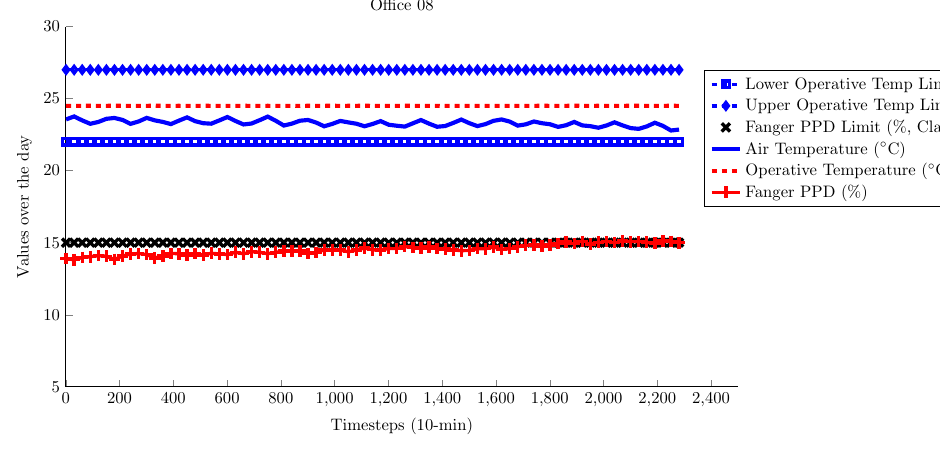
Figure 6. Summer results for Office 08 using the operative temperature thermostat set at 24.5 ◦ C.